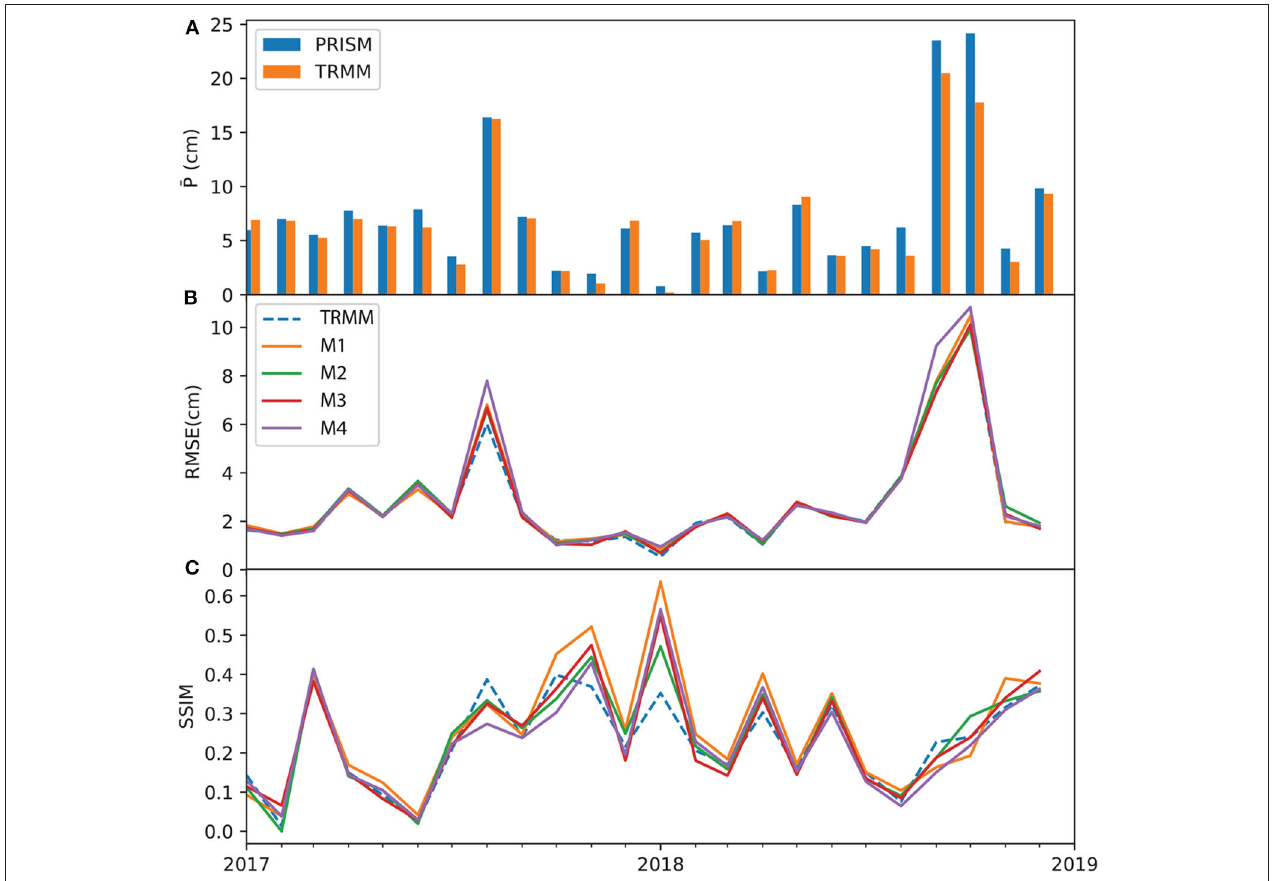
FIGURE 7 | Time series of TRMM metrics over the test period: (A) monthly averaged PRISM and TRMM data; (B) mean grid averaged RMSE; and (C) SSIM. All subplots share the same x axis.